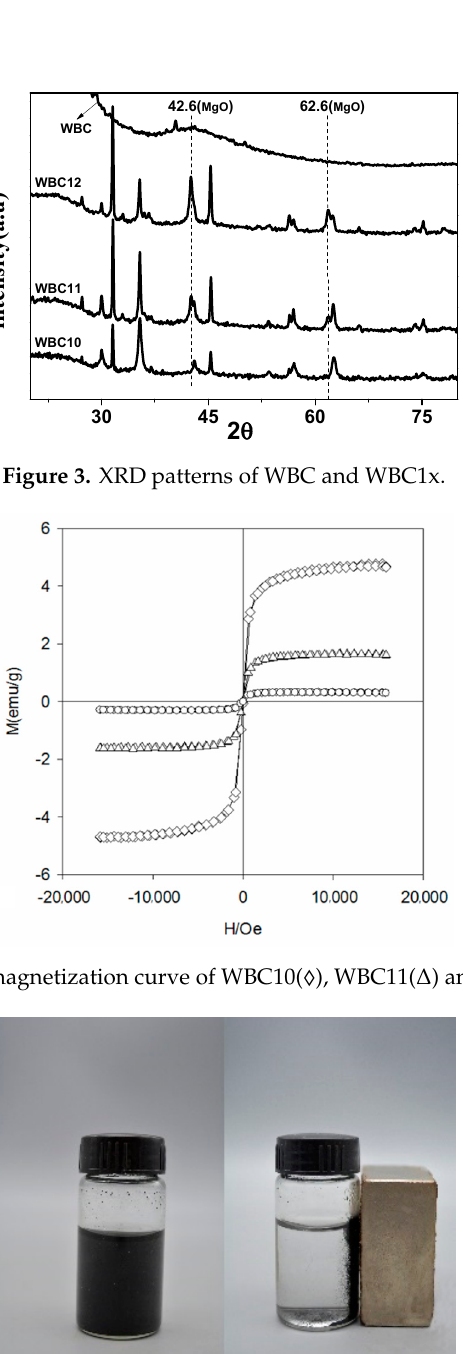
Figure 5. Magnetic separation of WBC12 after adsorbing phosphate from liquid solution.